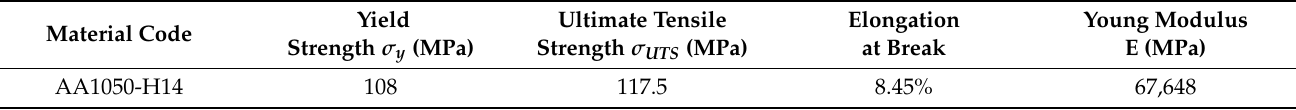
Table 2. Mechanical properties of aluminum alloy AA